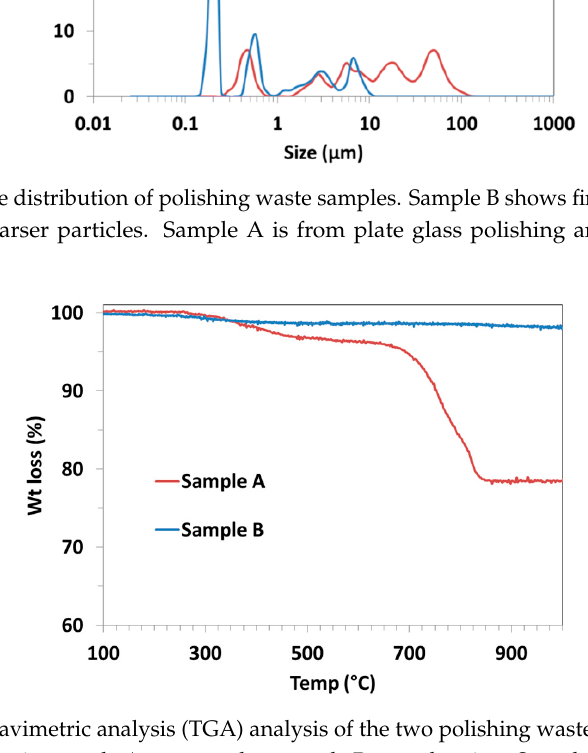
Figure 4. Thermo-gravimetric analysis (TGA) analysis of the two polishing waste samples shows high amount of weight loss in sample A compared to sample B upon heating. Sample A is from plate glass polishing and sample B is from mirror polishing.